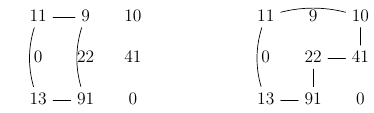
Figure 1. Five Stable Matchings (Matching C is Median-Stable)